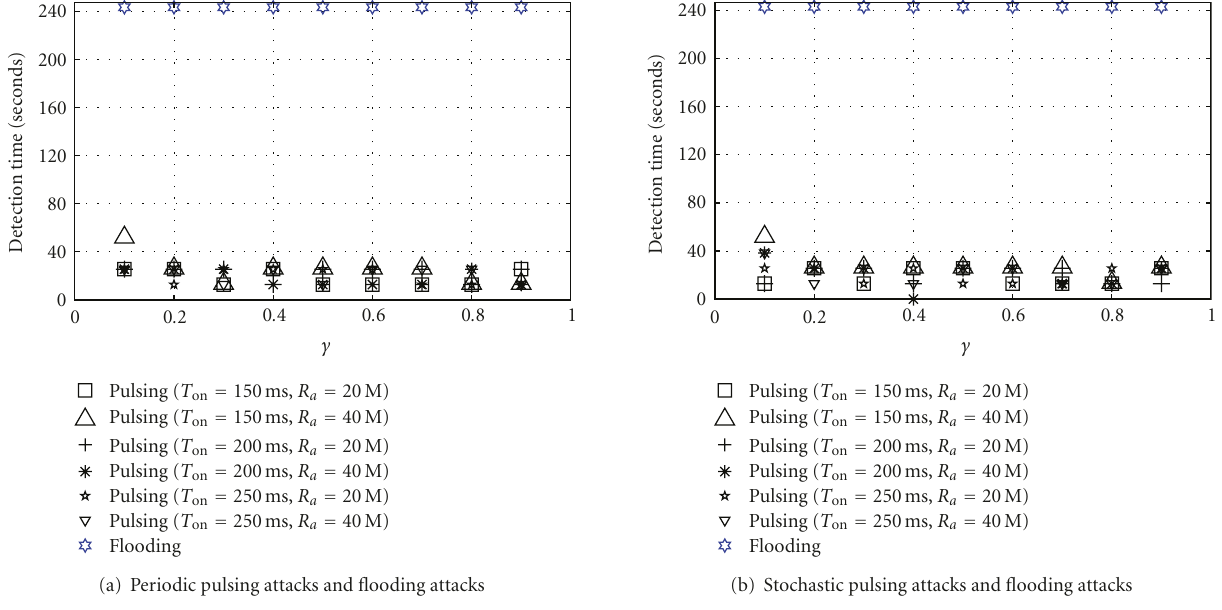
value p = 0 . 01. The period and the burst width of the low- rate attack signature template are 1.2 seconds and 0.2 second,